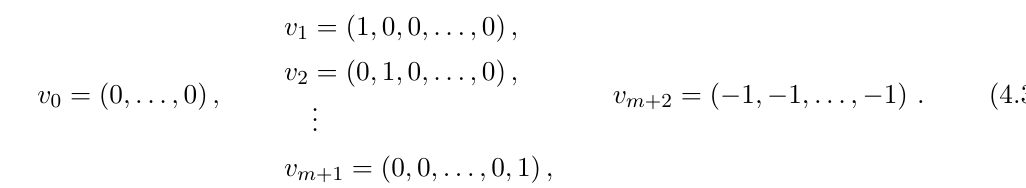
Figure 3. Toric diagrams for C m +2 = Z m +2 with m = 0 ; 1 ;